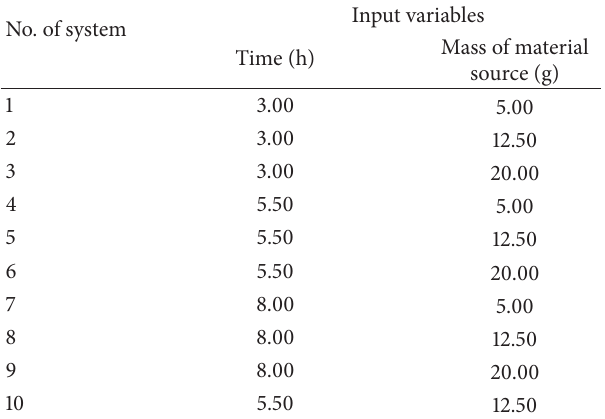
Table 1: Plan matrix for extraction